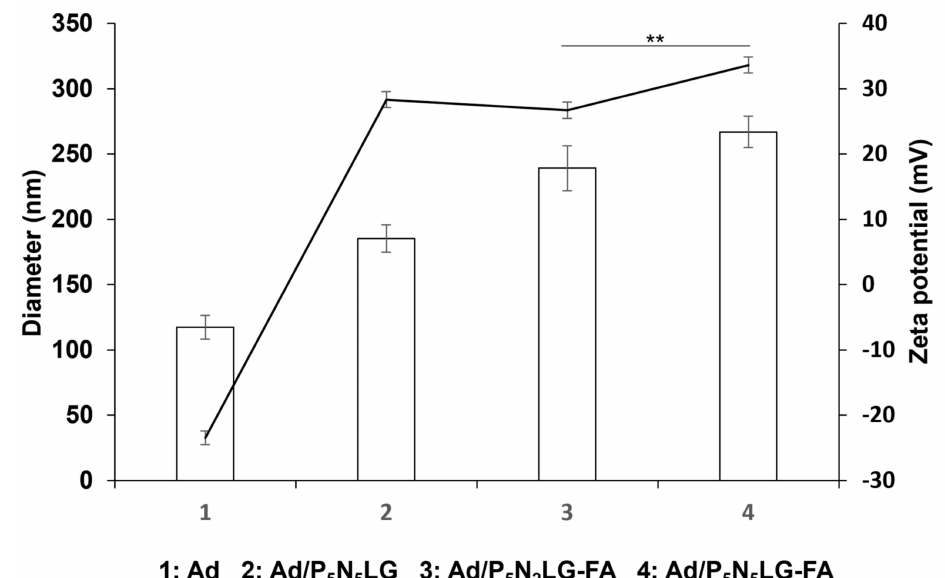
Figure 4. Physicochemical properties of Ad nanocomplexes. Average particle size and surface charge of naked Ad, Ad/P 5 N 5 LG, Ad/P 5 N 2 LG-FA, or Ad/P 5 N 5 LG-FA at Ad:polymer molar ratio of 5 × 10 5 were analyzed by Zetasizer. The data are representatives of triplicate samples. Bars represent mean ± SD. ** p <